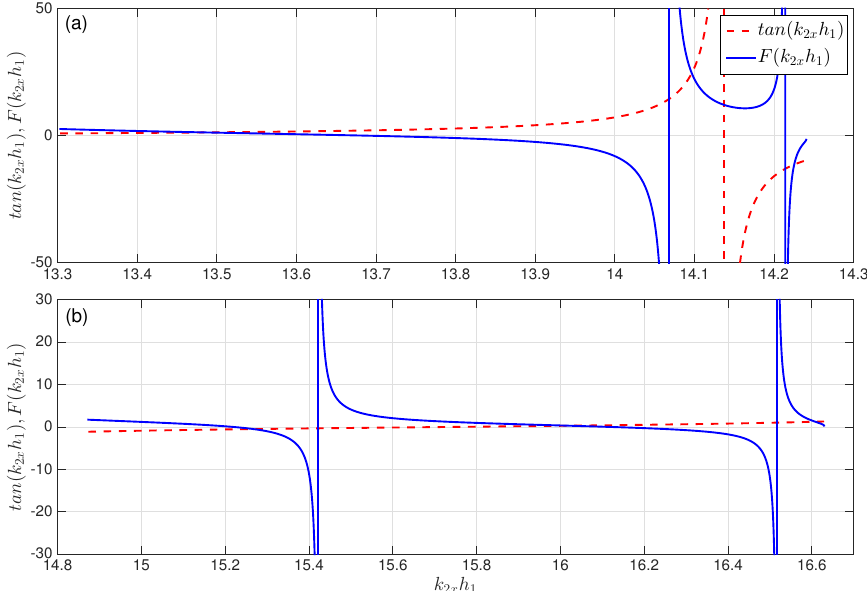
Figure 7. Graphical determination of k 2 x h 1 for guided modes in ( 0, h 1 + h 2 ) . The red and blue curves correspond to tan ( k 2 x h 1 ) and F ( k 2 x h 1 ) , respectively. The energy of incident electron is ( a ) E = 94 meV and ( b ) E = 110 meV. The other parameters are the same as those in Figure 2.